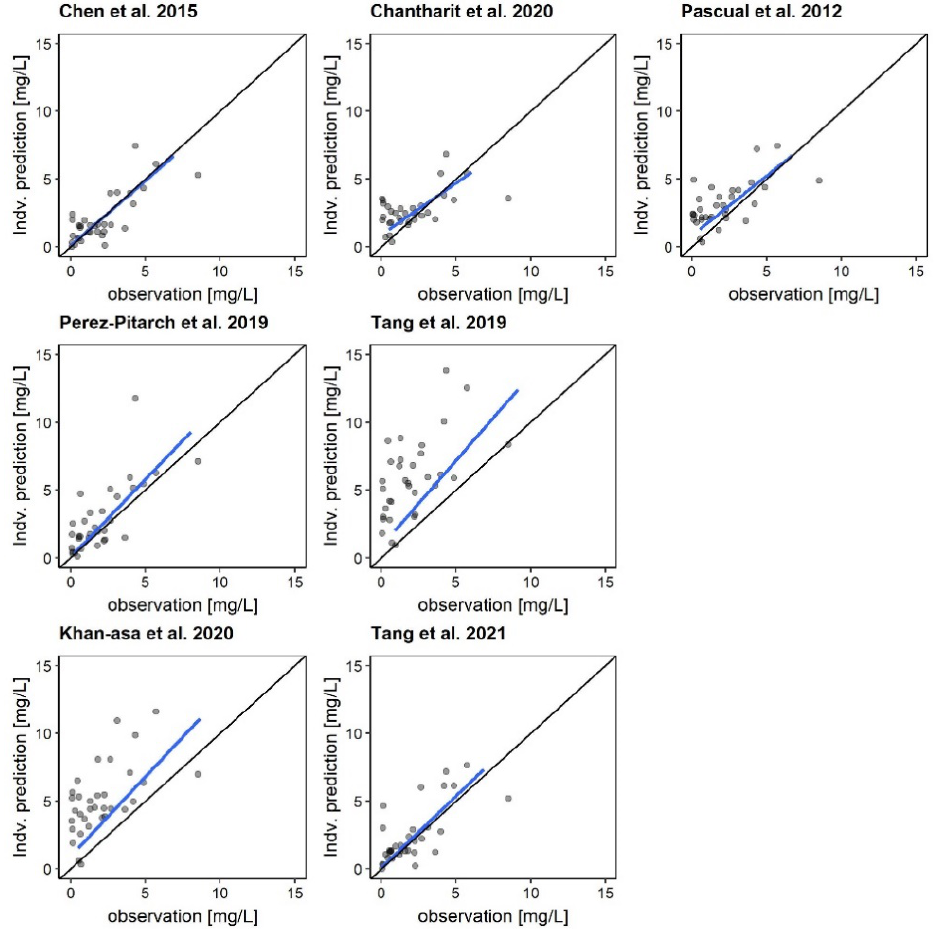
Figure 2. Goodness-of-fit plots for the investigated population PK models comparing individual predictions of the second measured plasma concentrations using the first plasma concentration and Bayesian forecasting [4,23–28]. Black line: line of identity; blue line: linear regression line. Points: measured concentrations.